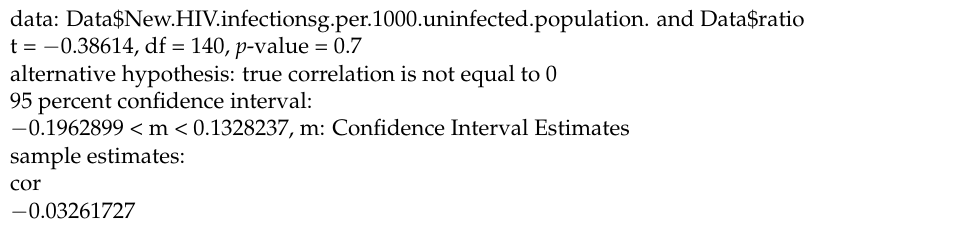
Table 9. STDs (HIV infection) infection rate according to life expectancy. data: Data$New.HIV.infectionsg.per.1000.uninfected.population. and Data$Life.expectancy.at.birth.years.